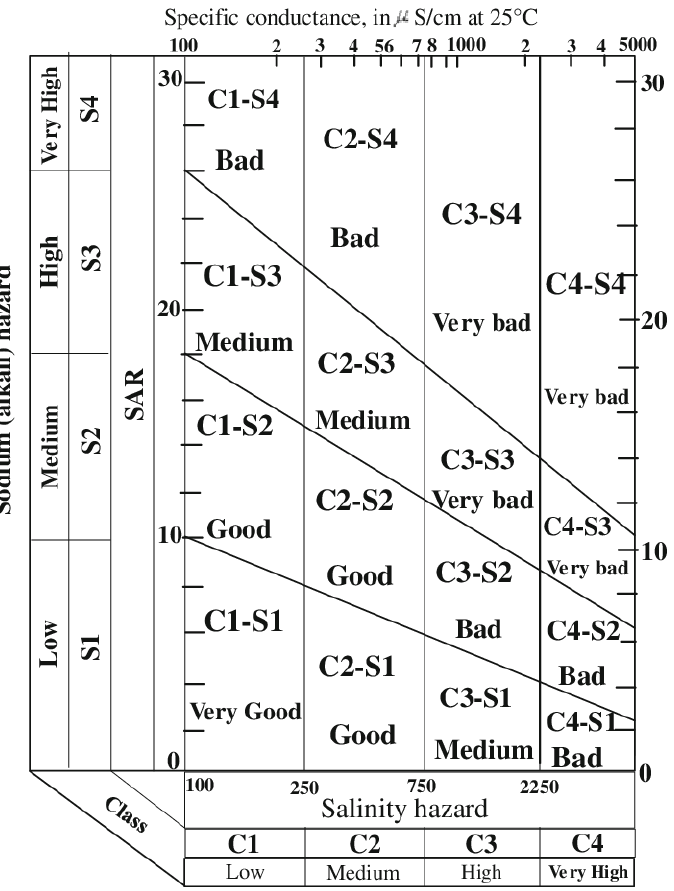
Figure 5. Wilcox diagram for classification of irrigation waters (modified after United States Salinity Laboratory Staff, 1954).